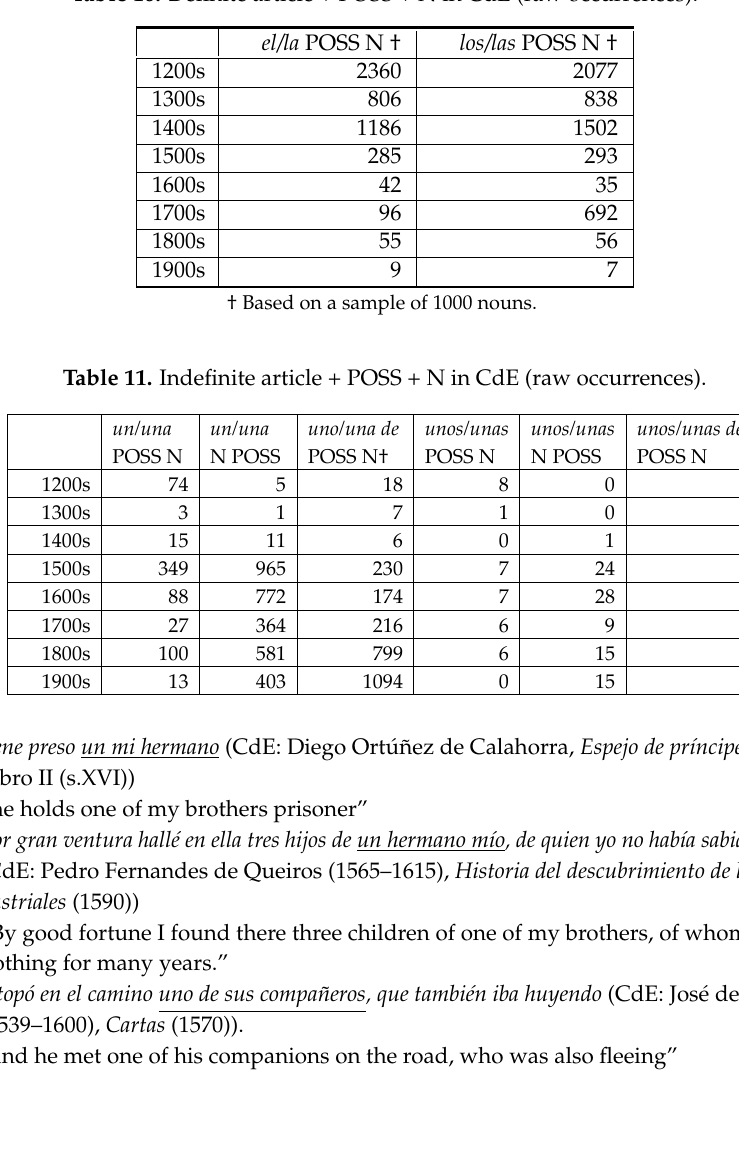
Table 10. Definite article + POSS + N in CdE (raw occurrences).